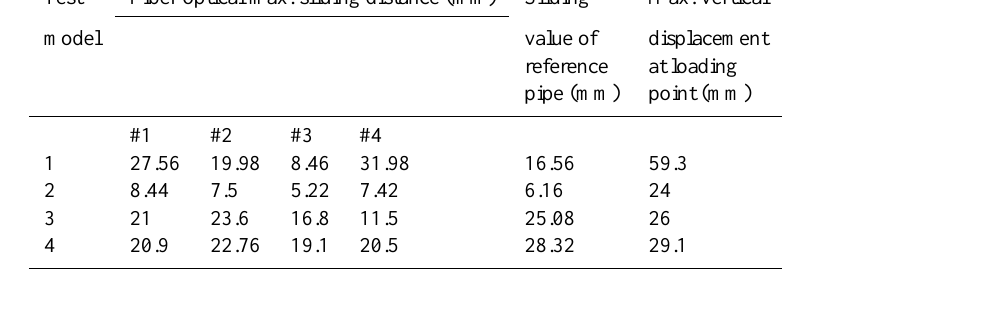
Table 3. Catalogue of fiber optical maximum sliding distance and vertical displacement at loading point of each model. Test Fiber optical max. sliding distance (mm) Sliding Max. vertical